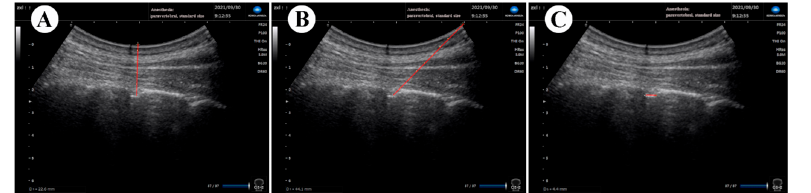
Figure 3. Example of ultrasonic image measurement in comfortable position. Vertical ( A ) and oblique distances ( B ) from the skin to the posterior dura and width of the interlaminar space were also measured ( C ) using the relevant “frozen image” of the ultrasound.